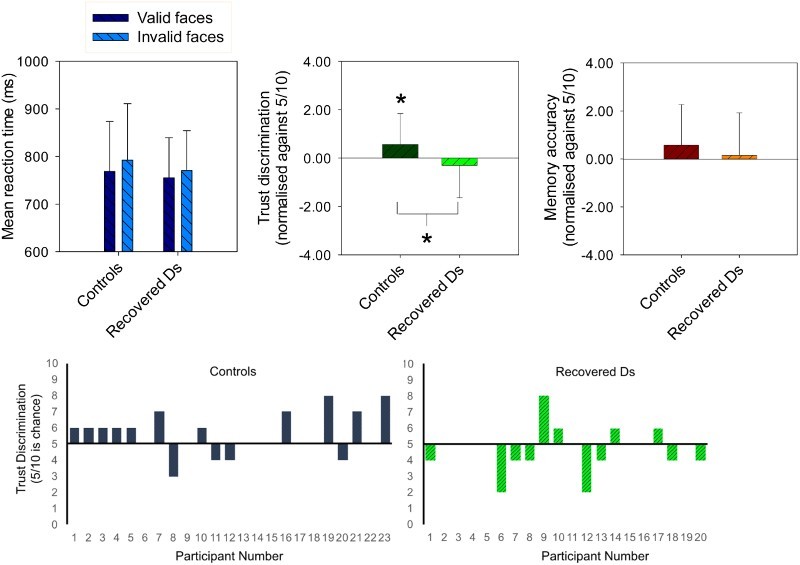
Top panel shows mean correct reaction time (ms ± SD) for target categorisations following valid and invalid faces in the gaze cueing task, and mean number of valid faces chosen as trustworthy and most frequently presented in 20 recovered-depressed adults and 23 age- and ability-matched never-depressed controls. The y-axes for the forced-choice trust and memory discriminations are normalised to chance (5/10 correct). *p < .05 from pair-wise and one-sample t-tests. Bottom panel shows individual participant data for the critical trustworthiness judgement task (i.e. individual data points that contributed to the central graph of the upper panel of this figure). Chance level performance is where a participant selects five valid cue faces and five invalid cue faces as trustworthy, hence bars above the line indicate that the participant had a bias to select more “valid” gaze cue than “invalid” gaze cue faces.